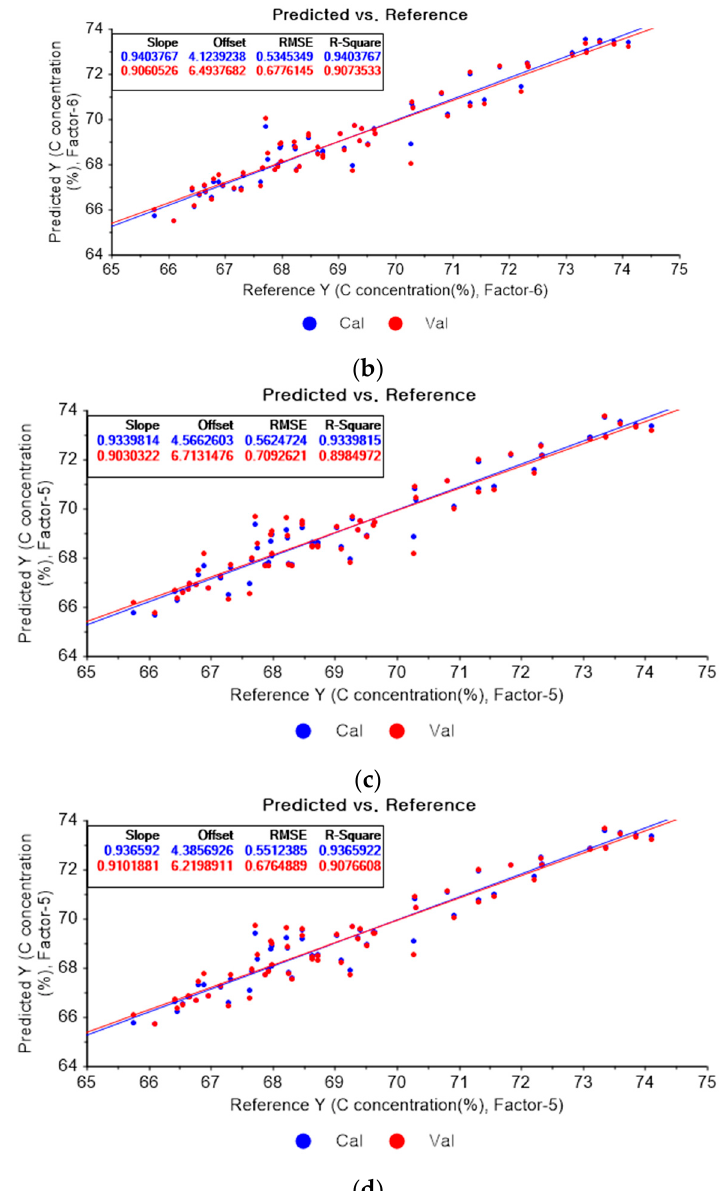
Figure 5. PLSR model of carbon concentration with ( a ) the original data and PLSR models pre-processed with SG derivative by utilizing ( b ) first-order derivative and third-order polynomial with five points, ( c ) first-order derivative and third-order polynomial with seven points, and ( d ) first-order derivative and third-order polynomial with nine points.